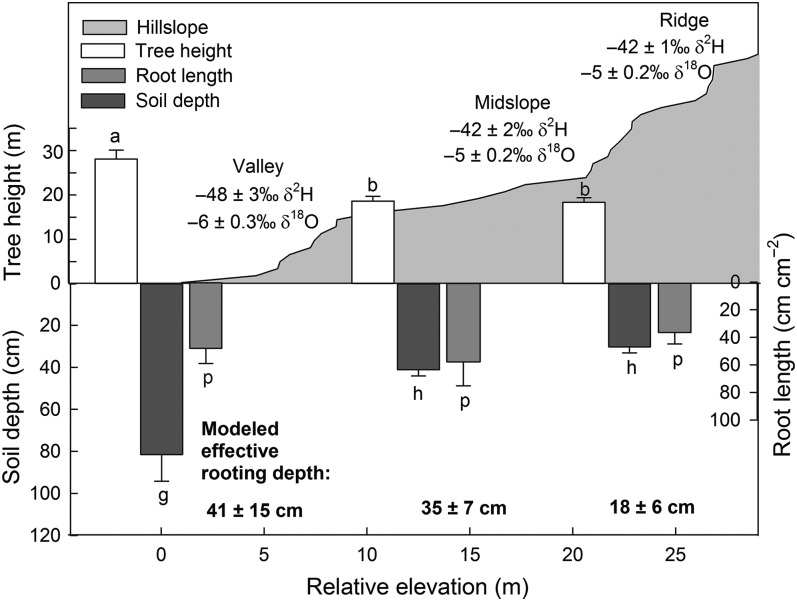
Depiction of Shale Hills catchment and related plant and soil traits with relative slope position and relative elevation. Values shown indicate mean ± standard error. Tree water isotope data shown are for dry dates. Tree height and soil depth at tree locations are for all trees sampled during the study. Tree height (P < 0.001) and soil depth (P < 0.0001) varied by slope position (differences denoted with letters), while root length did not (P = 0.5). Average δ2H and δ18O compositions shown for trees at each slope position (top), along with effective rooting depth estimates (bottom, shown for illustrative purposes only). Isotopic compositions varied by soil depth, but not by slope position. Error bars represent mean ± standard error.